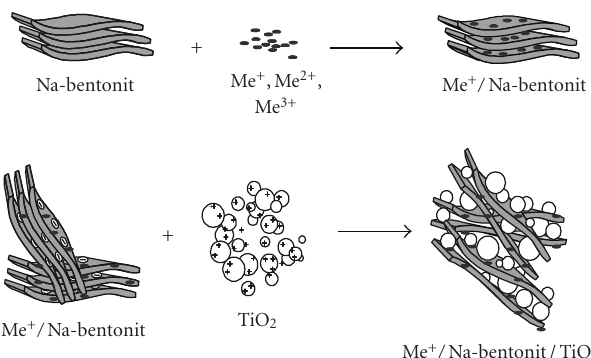
Figure 2: Schematic drawing of preparation of Me-ion exchanged montmorillonite/TiO 2 composites.